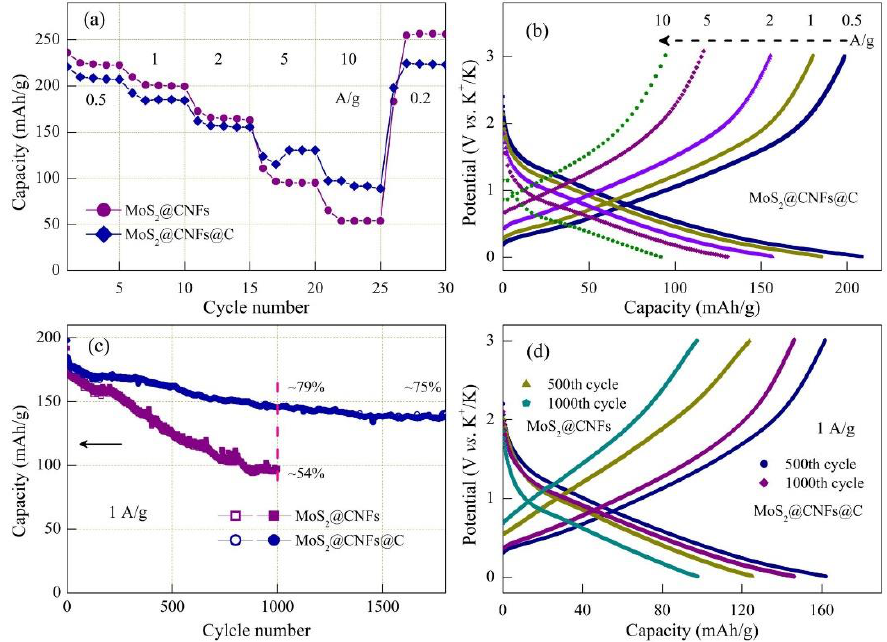
Figure 5. ( a ) Rate performance of MoS 2 @CNFs and MoS 2 @CNFs@C at different current densities, ( b